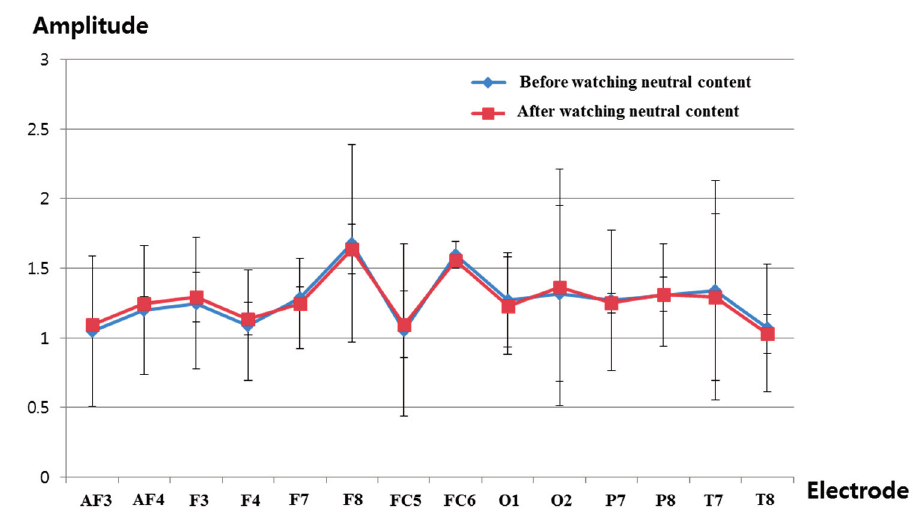
Figure 20. Ratios of delta band to beta band of EEG data before and after watching the video clip of emotionally-neutral content to the